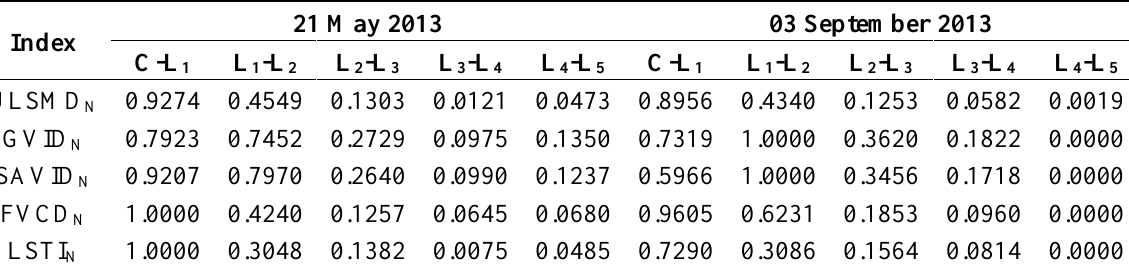
Table 7. The normalized processing value of ULSMD, GVID, SAVID, FVCD and LSTI. C refers to core area, L i (i = 1,2,3,4,5) refer to each layer of buffer